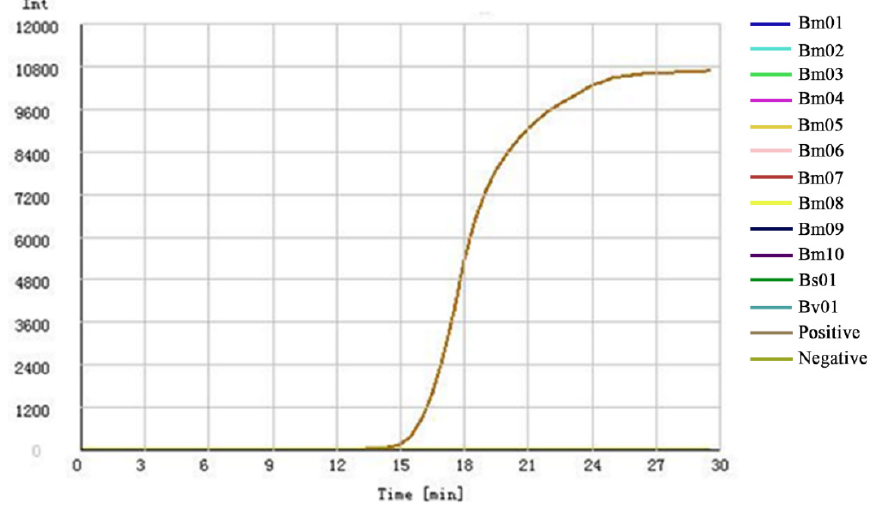
Figure 6. DNA amplification curve from EMA of different strains and Bursaphelenchus species.